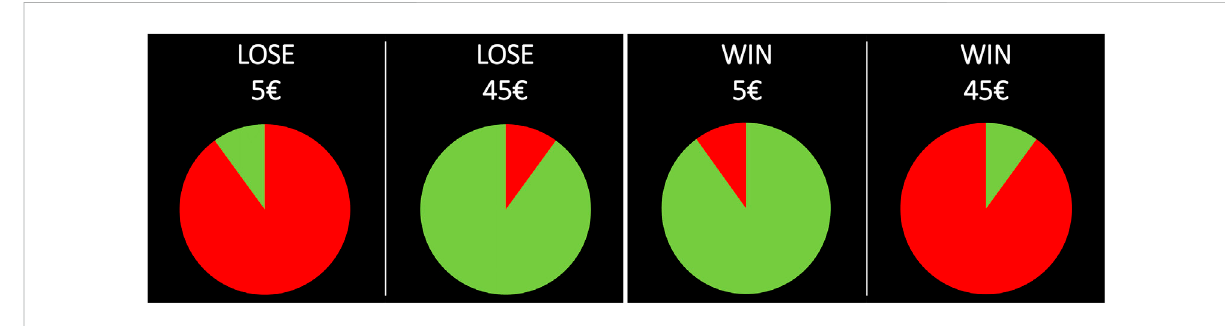
FIGURE 1 Examples of pairs of bets used in the decision-making task in the loss domain (on the left) and in the gain domain (on the right) with the probability of losing (or not winning) in red and the probability of winning (or not losing) in